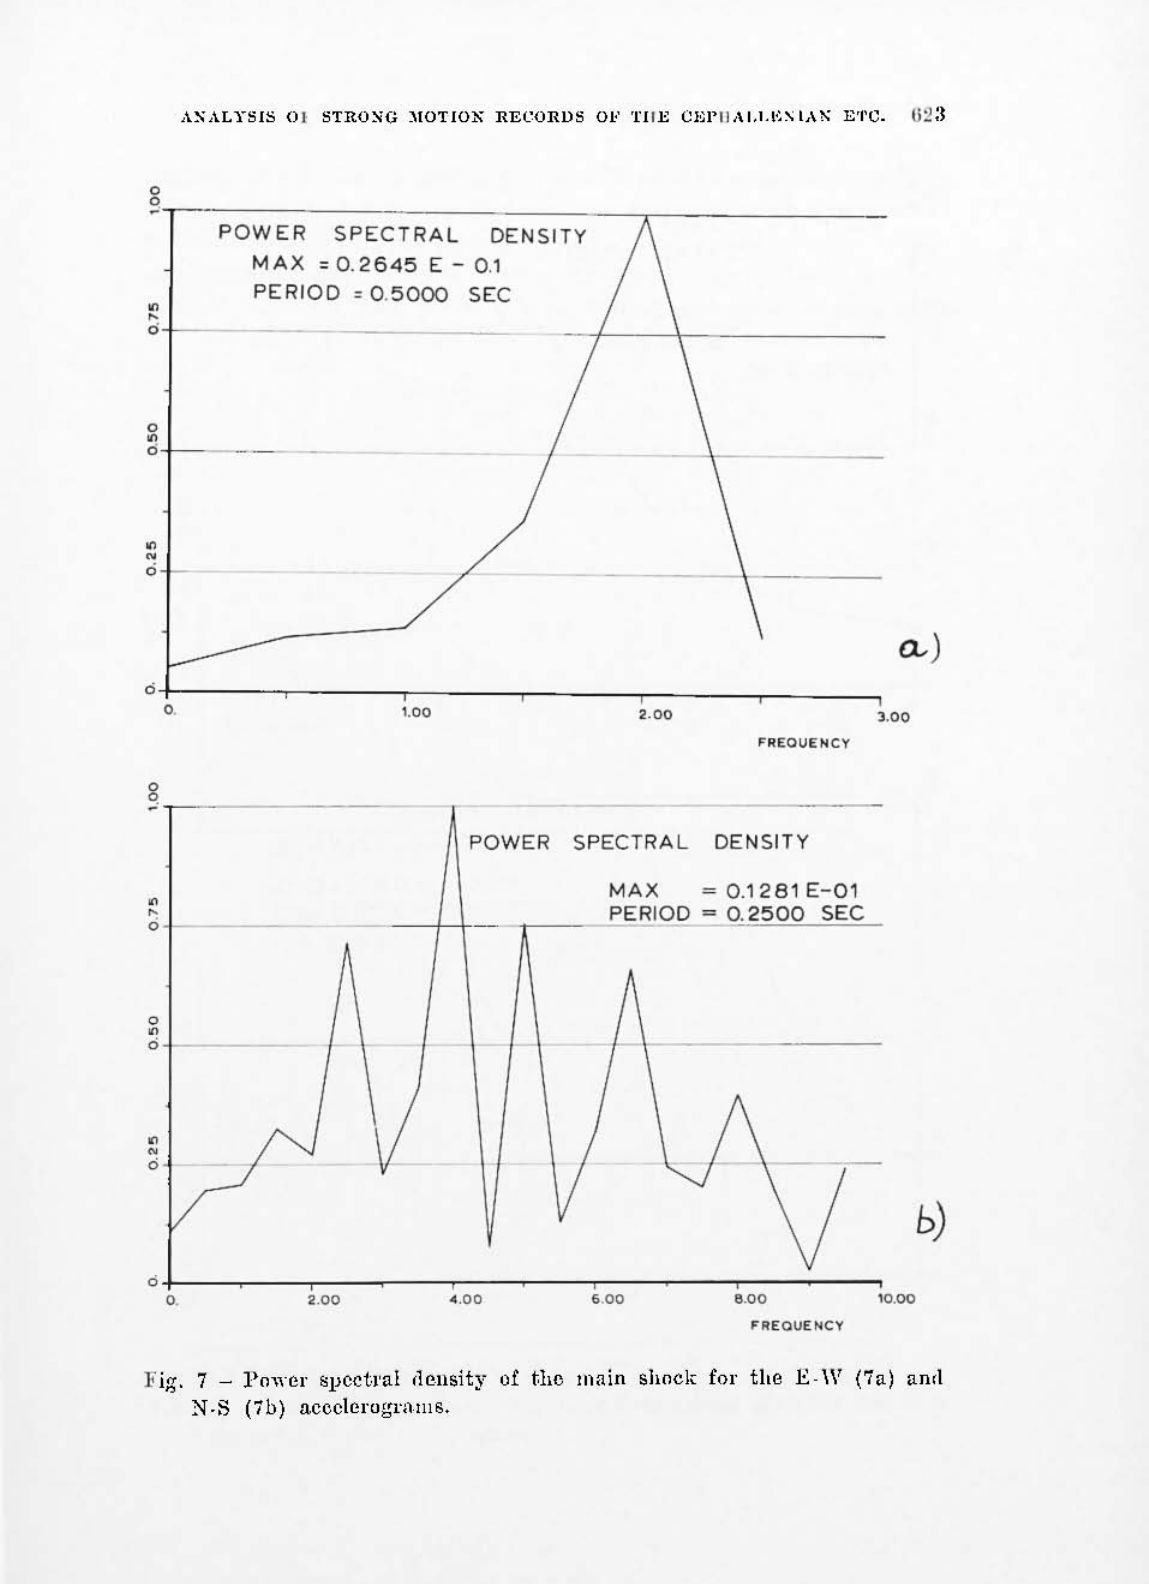
Fig. 7 - l'ower speetl'al t1eusity or thc lllain shock for the E-W (ia) antl N·S (ib)